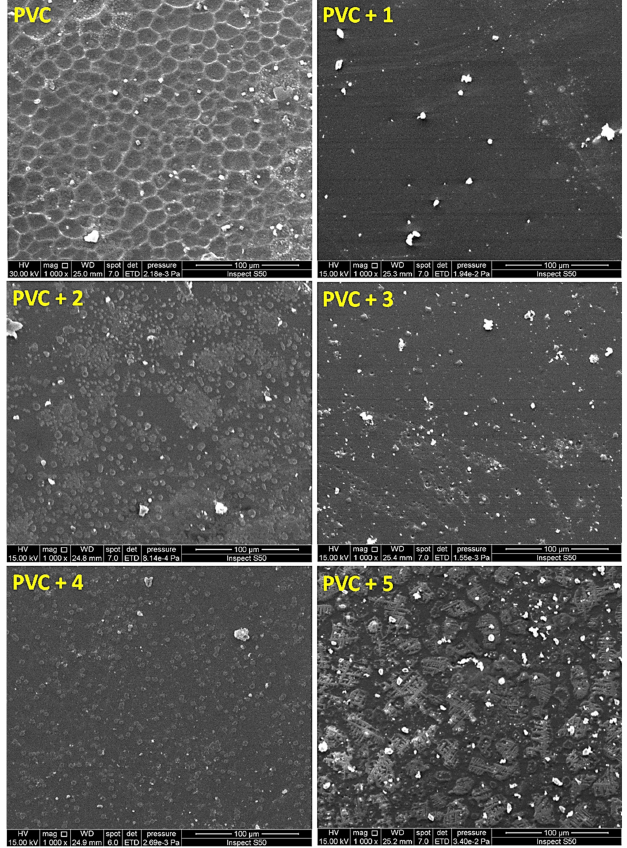
Figure 9. SEM images of irradiated PVC